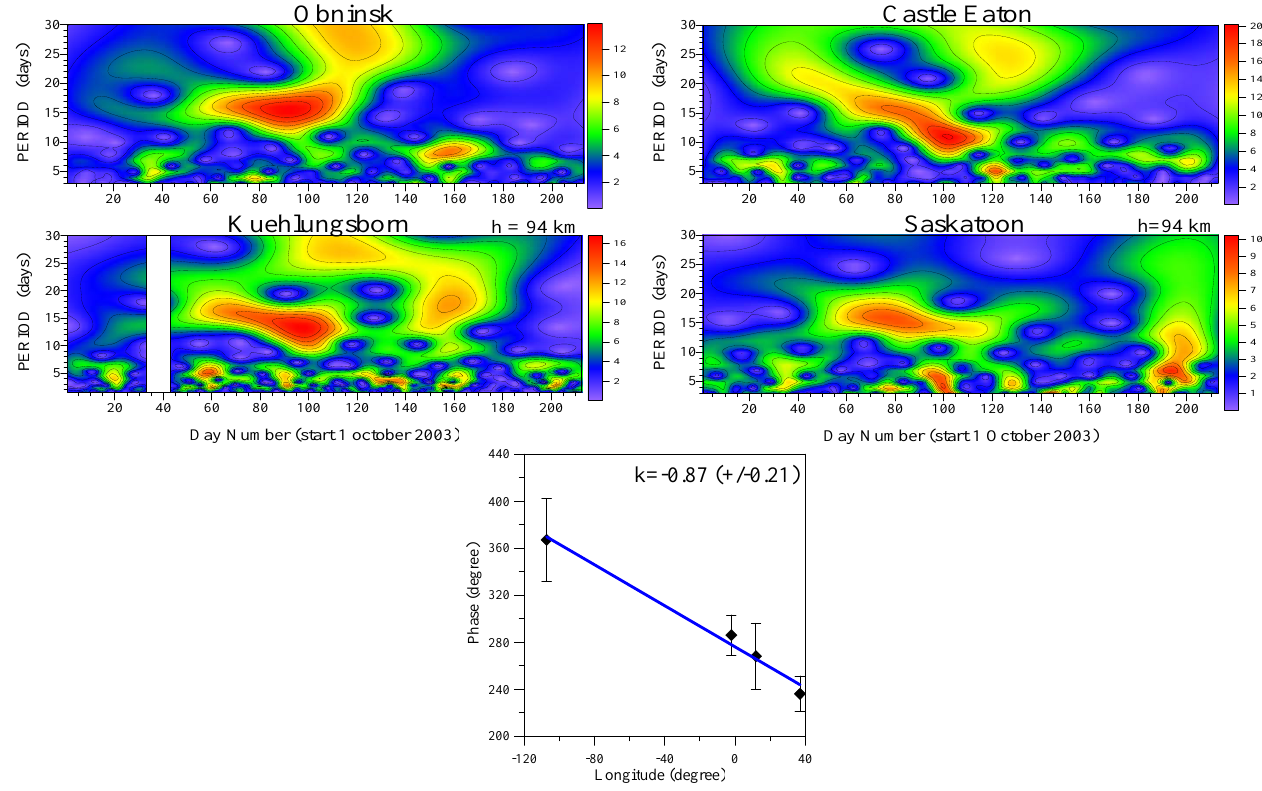
Figure 11 Fig. 11. Wavelet spectra calculated in the period range from 3 to 30 days for the zonal wind measured at the mid-latitude stations: Obninsk and Castle Eaton (upper row) and Kuehlungsborn and Saskatoon (bottom row). The bottom plot shows the longitudinal distribution of ∼ 16-day wave